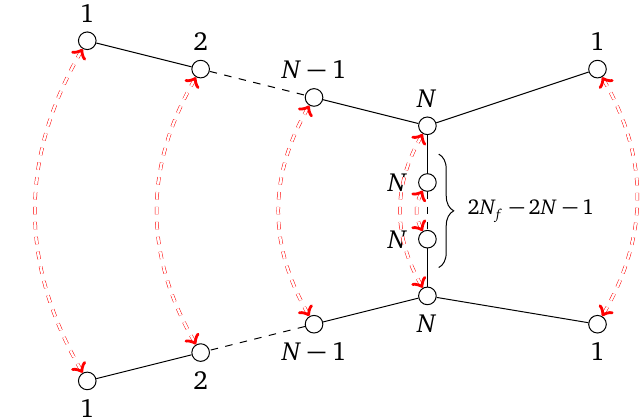
Figure 8: Wreathed quiver for SQCD-like theories with gauge group (cid:221) SU ( N ) > N flavours. There is a single (cid:90) N f horizontal axis. The global symmetry of this wreathed quiver is Sp ( N